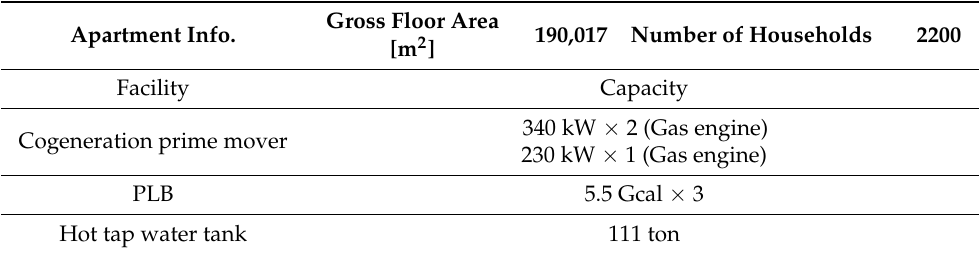
Table 4. Design information for the apartment complex and the cogeneration system configuration in Case D. Apartment Info.